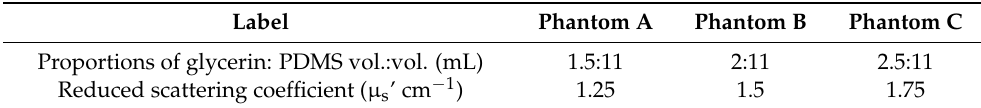
Table 1. Compositions and descriptions of the prepared phantoms. Label Phantom A Phantom B